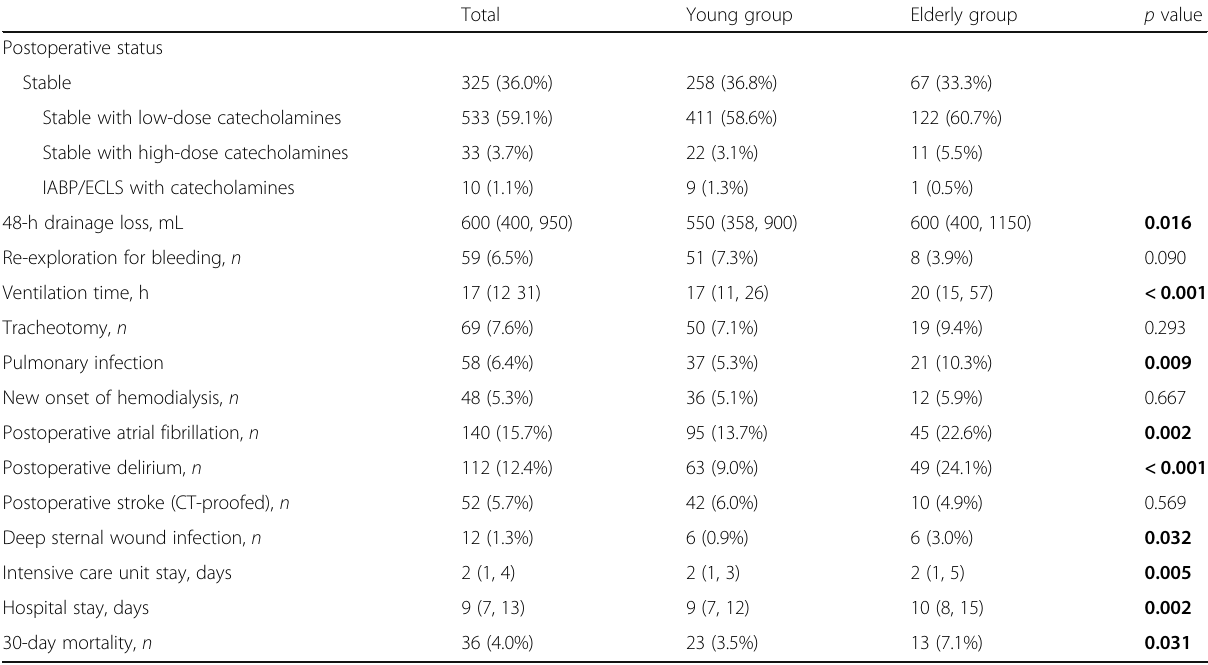
Table 3 Postoperative data and outcomes